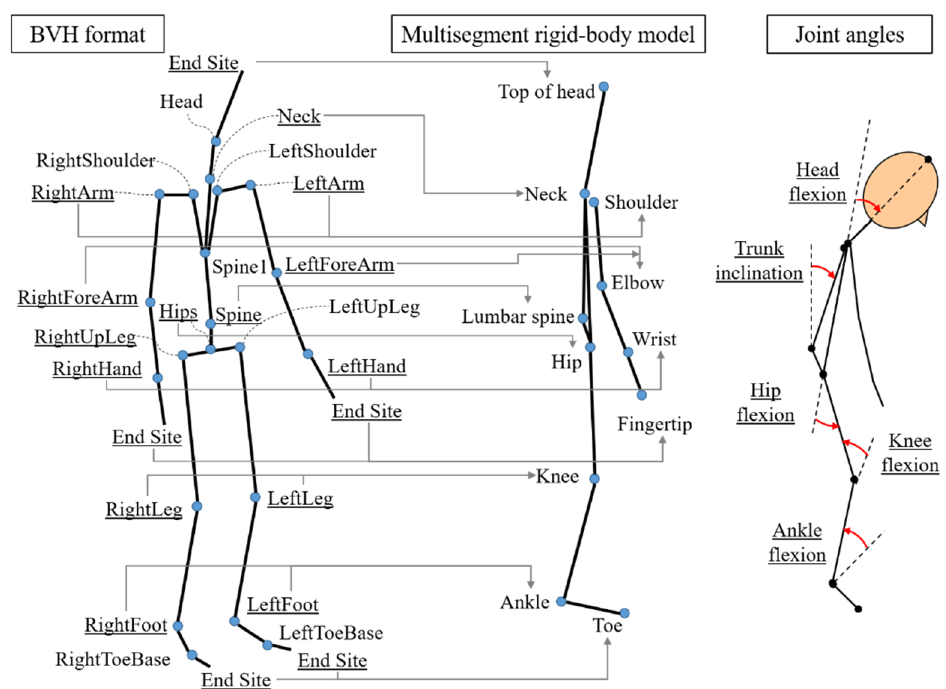
Figure 3. The model of the BVH format and the nodes used for calculating the joint positions and the definitions of the joint angles. The underlined nodes in the BVH model are adopted as the body joints in the multisegment rigid-body model.